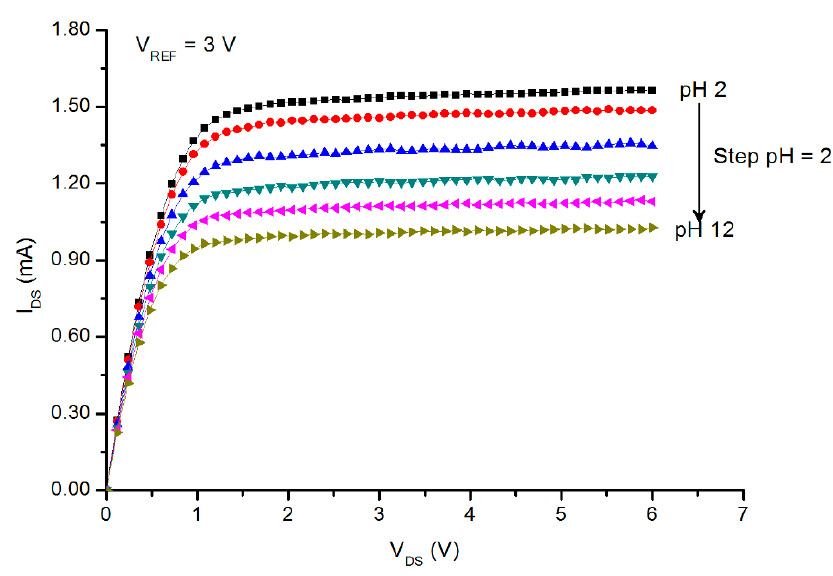
Figure 7. Plot of the I DS vs. the V DS of the prepared PSi pH sensor. V REF was kept constant at 3 V. Buffer solutions were pH = 2–12.